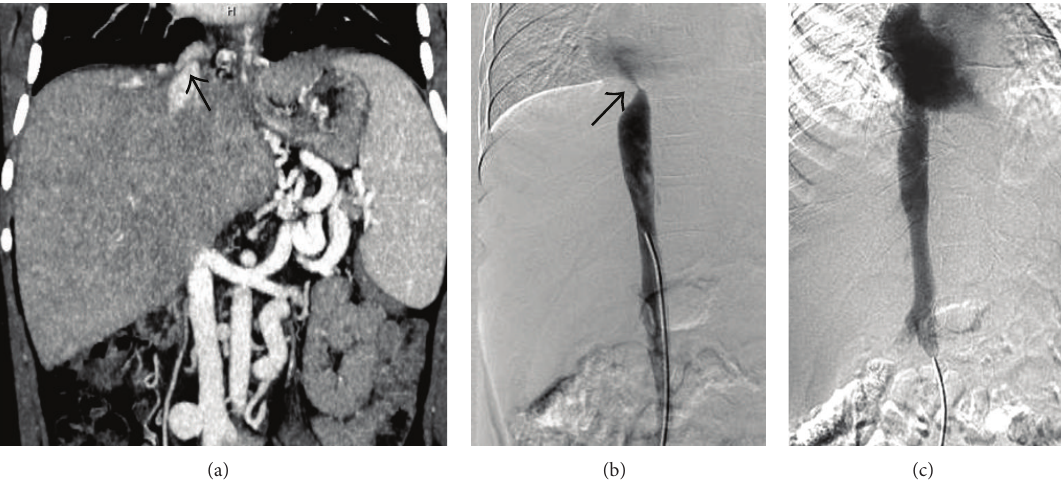
Figure 19: Coronal CECT image (a) showing an IVC web (arrow). IVC angiogram (b) of the same patient showing a jet of contrast (arrow) entering the right atrium signifying the obstruction caused by the web. Postangioplasty image (c) shows resolution of the stenosis.